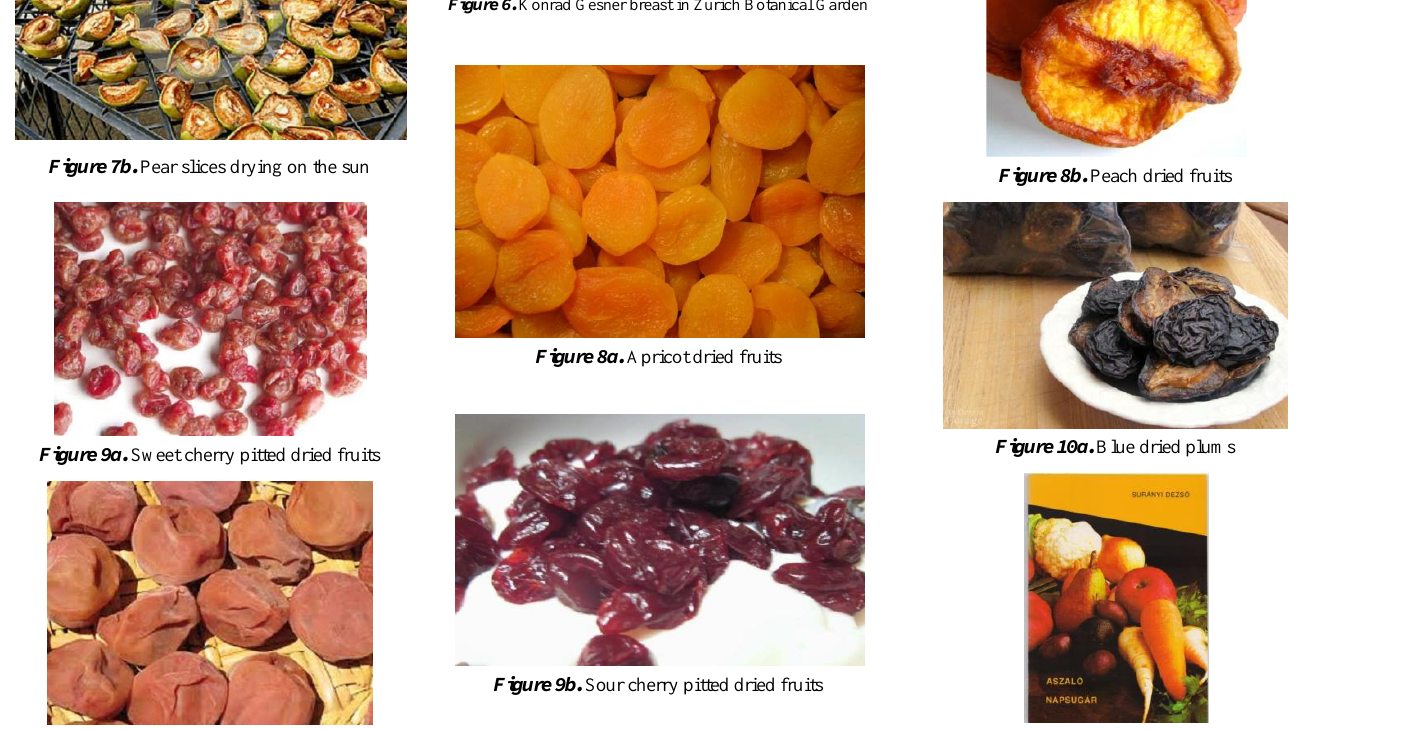
Figure 9b. Sour cherry pitted dried fruits Figure 10b. Black dried plums Source: Figure 2, 3, 4: Magyar Néprajzi Lexikon; Figure 1, 5, 6, 7, 8, 9, 10, 11: author’s